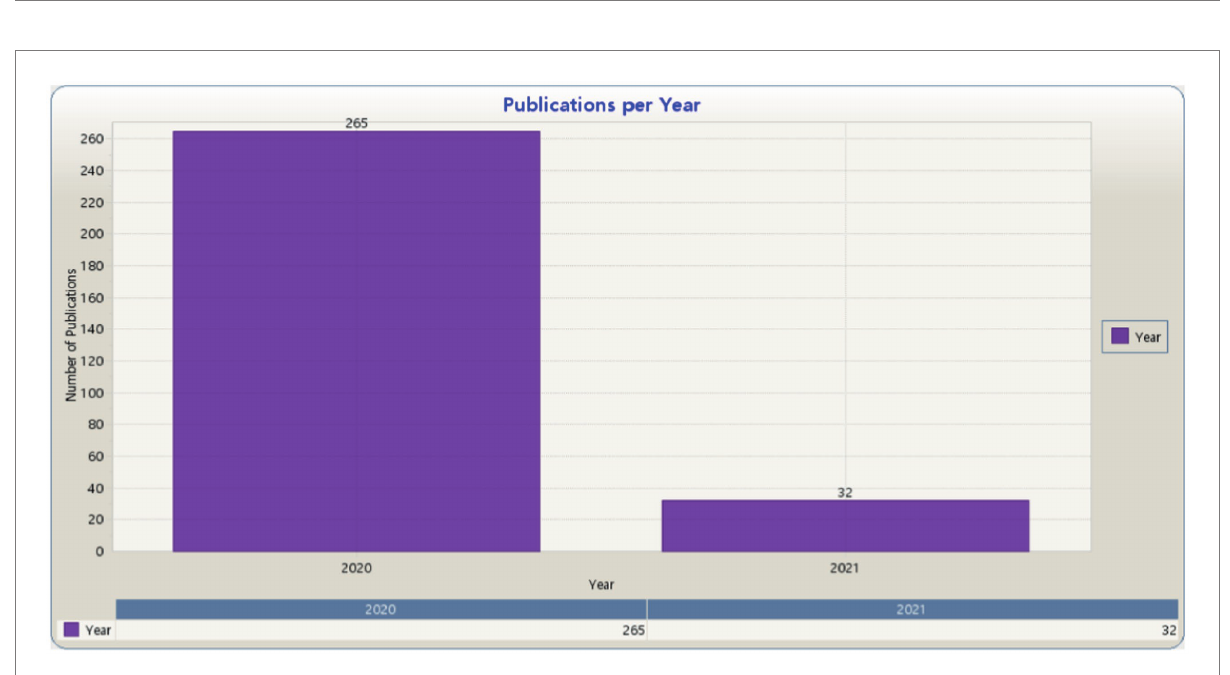
FIGURE 3 Publications per year in Science Direct (KnowledgeMatrix Plus